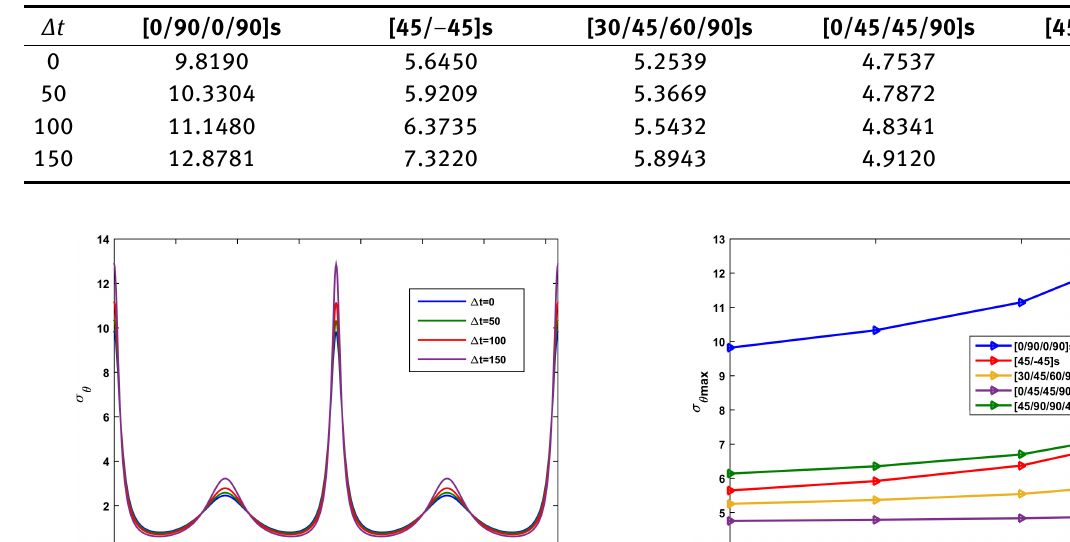
Table 2: Effect of ∆t and stacking sequence on σ θ max (a/b = 2, σ ∞ x = σ ∞ x = 1 )